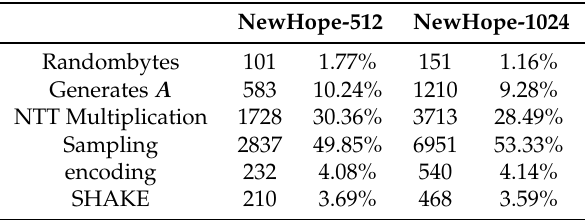
Table 8. Percentage of computational load in NewHope